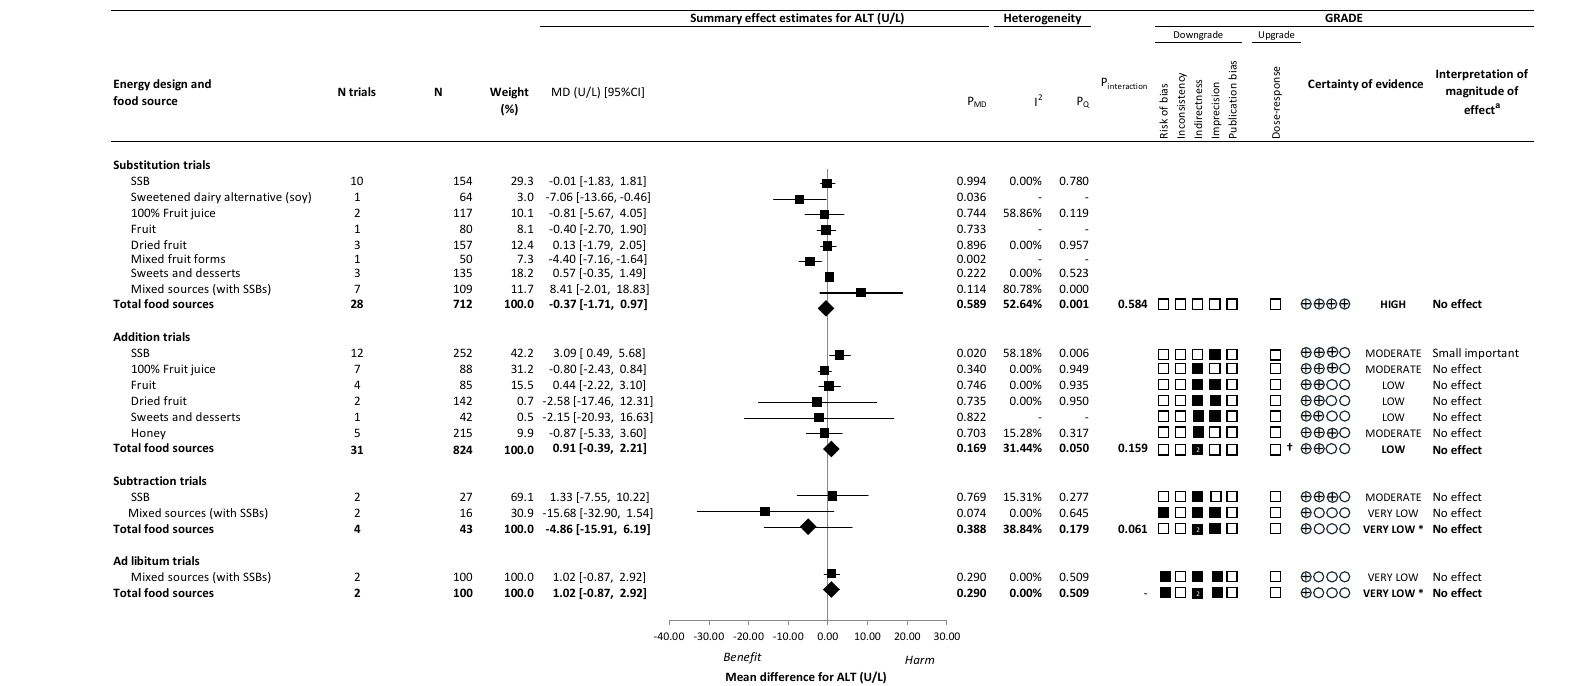
Figure 3. Summary plot for the effect of important food sources of fructose-containing sugars on alanine aminotransferase (ALT). Data are weighted mean differences (95% confidence intervals) for summary effects of individual food sources and total food sources on ALT. Analyses conducted by generic, inverse variance random effects models (at least five trials available) or fixed effects models (fewer than five trials available). Between-study heterogeneity was assessed by the Cochrane Q statistic, where P Q < 0.100 is considered statistically significant, and quantified by the I 2 statistic, where I 2 ≥ 50% is considered evidence of substantial heterogeneity. The Grading of Recommendations, Assessment, Development and Evaluation (GRADE) of randomized controlled trials are rated as “High” certainty of evidence and can be downgraded by five domains and upgraded by one domain. The white squares represent no downgrades, while filled black squares indicate a single downgrade or upgrades for each outcome, and the black square with a white “2” indicates a double downgrade for each outcome. ALT = alanine aminotransferase; CI = confidence interval; GRADE = Grading of Recommendations, Assessment, Development and Evaluation; MD = mean difference; N = number; SMD = standardized mean difference; SSB = sugar-sweetened beverage. a For the interpretation of the magnitude, we used the MIDs to assess the importance of magnitude of our point estimate using the effect size categories according to new GRADE guidance. † Not upgraded for dose–response (see Table S7 for details). * Where there was a significant interaction by food source in substitution and addition trials and SSBs and mixed sources were the sole food sources in subtraction and ad libitum trials, we performed the GRADE analysis for each individual food source. To convert U/L to ukat/L, multiply U/L by 0.0167.